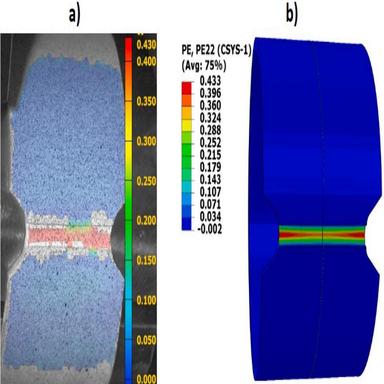
Distribution of the true major strains in the gauge section of the GRHPST: (a) experimental results; (b) simulation results.